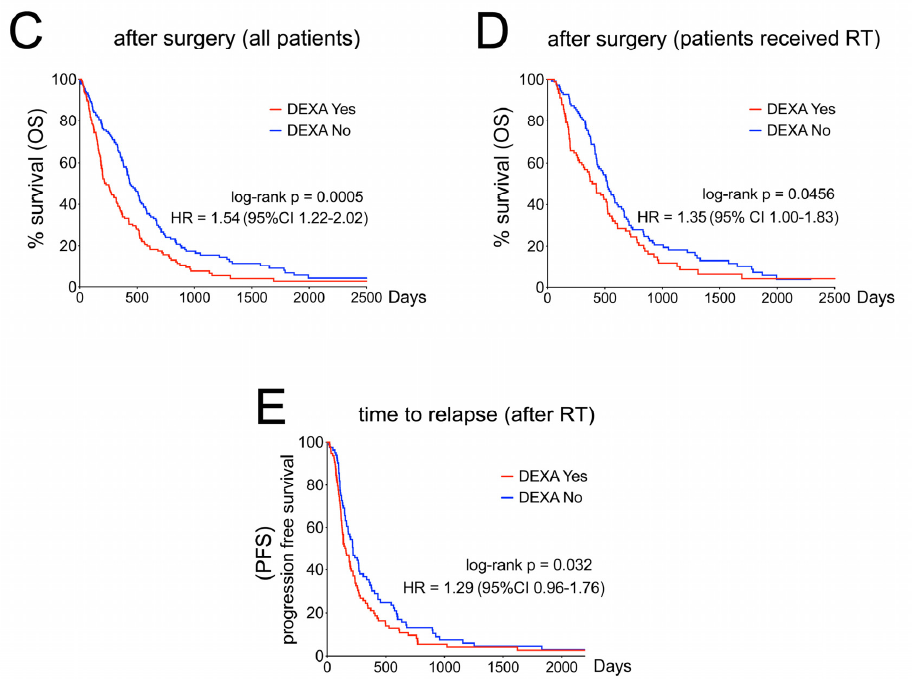
Figure 1. Dexamethasone protects from radiotherapy and reduces survival in glioblastoma (GBM) patients. ( A ) Schematic showing workflow of the FDA approved drug screen. T98G cells were treated with a library of 978 FDA approved drugs at 10 µ M, exposed to a single dose of 12 Gy and 96 h later analysed for survival using crystal violet staining. ( B ) 26 drugs selected in the first screen were re-screened at concentrations of 1, 10 and 25 µ M using 6 Gy. Thirteen glucocorticoids identified in this second screen are shown. Dimethyl sulfoxide (DMSO) was set = 1. ( C ) Kaplan-Meier analysis of the Biodonostia patient cohort. Differences in overall survival for patients receiving no corticosteroids ( n = 141) or dexamethasone ( n = 144) are shown. Hazard ratio and p (log-rank) are indicated. ( D ) Kaplan-Meier analysis of the Biodonostia cohort of patients who underwent radiotherapy ( n = 207). Differences in overall survival for patients receiving basal ( n = 93) or no ( n = 114) dexamethasone are shown. Hazard ratio and p (log-rank) are indicated. ( E ) Kaplan-Meier analysis for progression free survival after radiotherapy for patients receiving no ( n = 114) or basal dexamethasone ( n = 93). Hazard ratio and p (log-rank) are